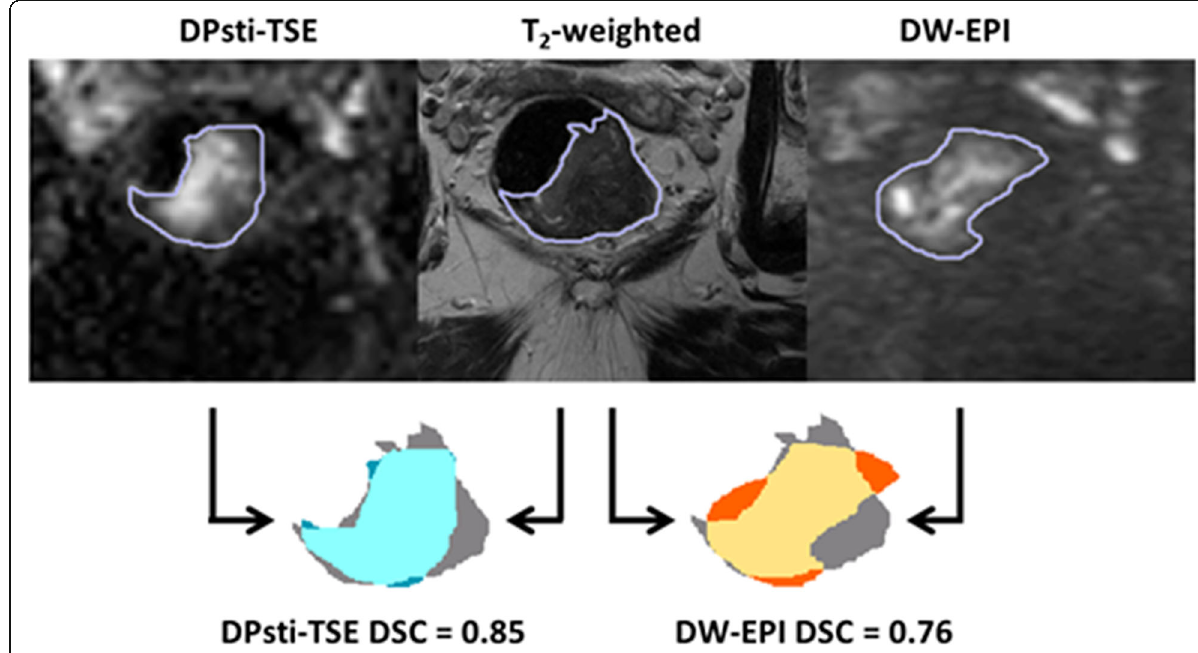
Fig. 1 Illustration of the DSC calculation. First, tumour ROIs for a rectal motion-free slice (b = 1000 s/mm 2 ) were delineated using the two-step drawing approach. DSC values were then calculated for DPsti-TSE ROI and DW-EPI ROI separately. The DSC value is the ratio of the overlapped area to the mean area of two ROIs, from a DW image and the T2-weighted image, respectively. ( DPsti-TSE diffusion-prepared stimulated echo turbo spin-echo, DSC Dice similarity coefficient, DW-EPI diffusion-weighted echo-planar imaging, ROI region of